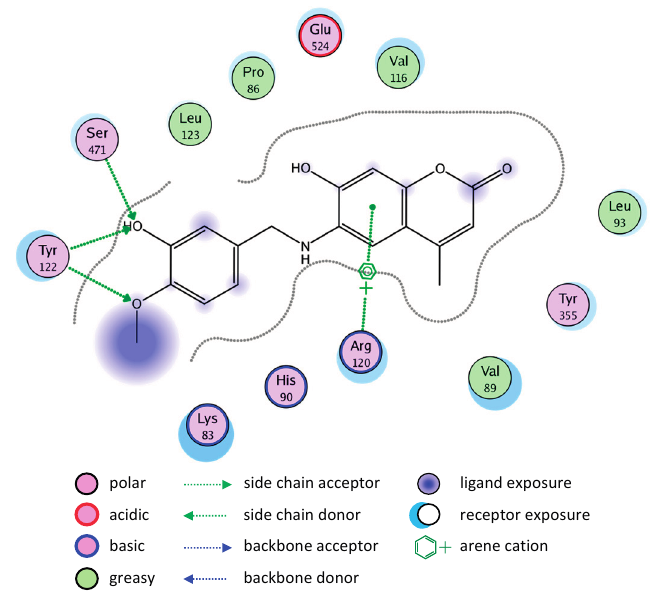
Figure 5. 2D representation of docking of compound 8 into the COX-2 active